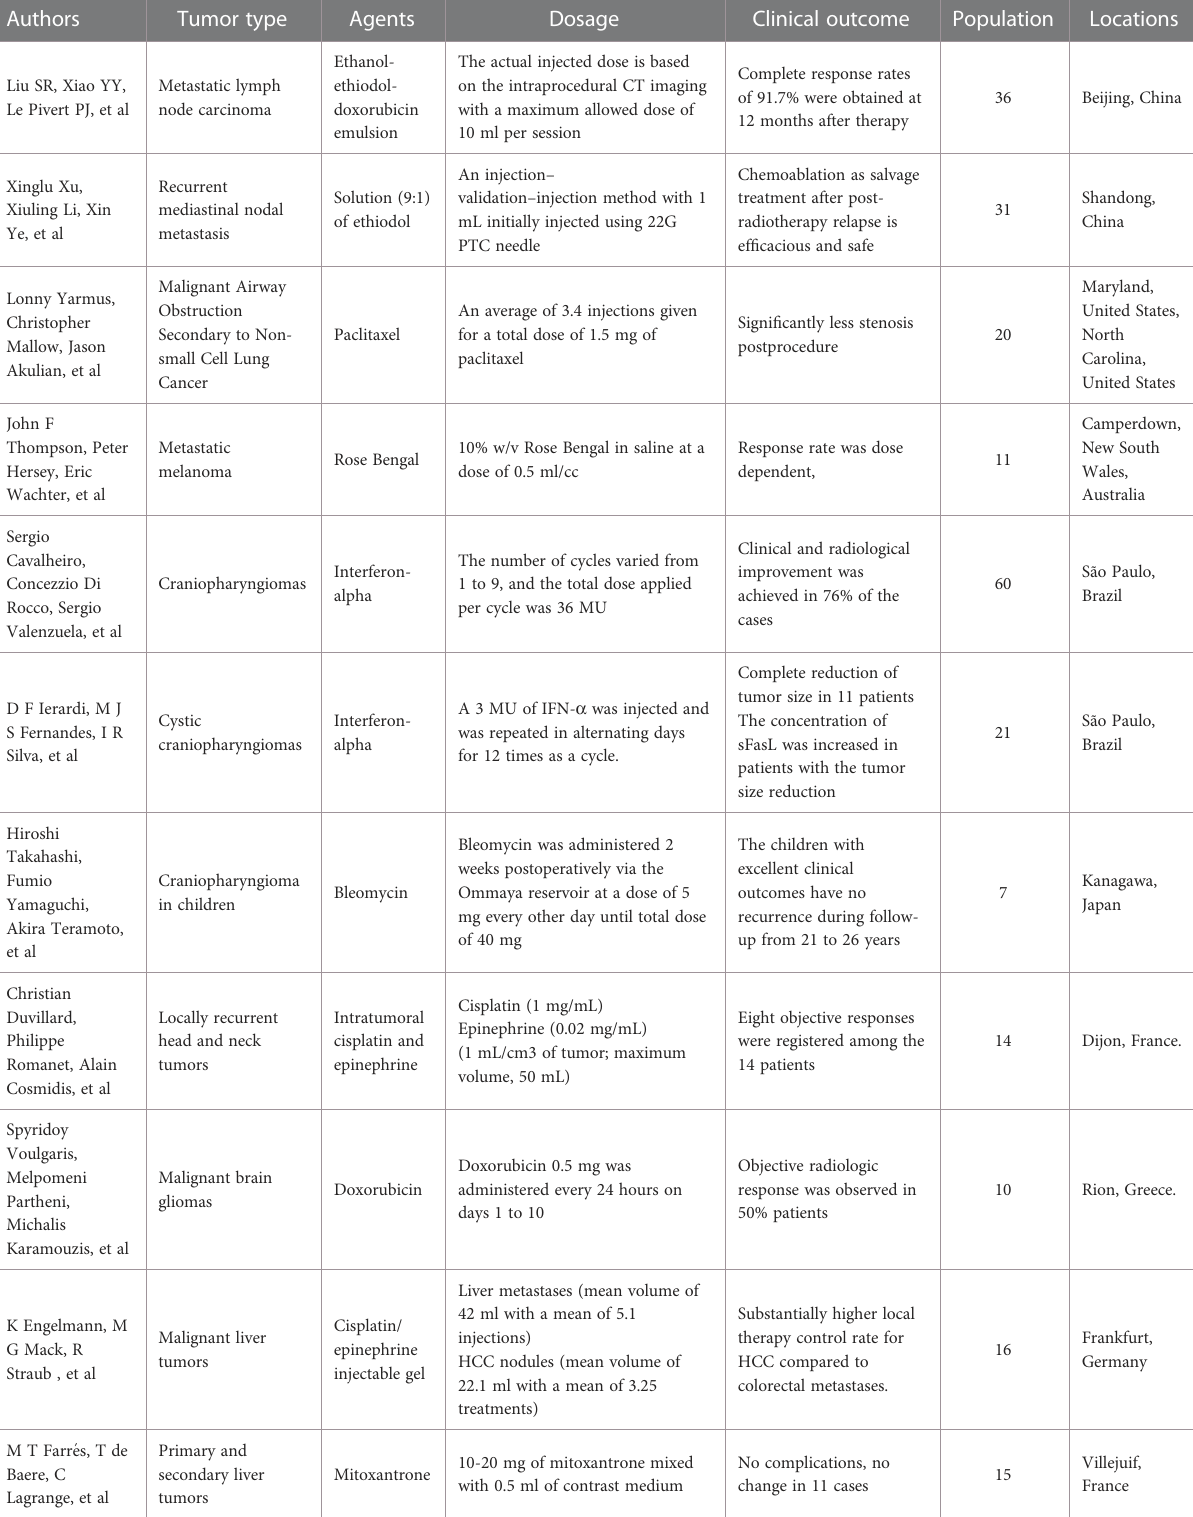
TABLE 1 Selected clinical trials of chemical ablation of different tumors.